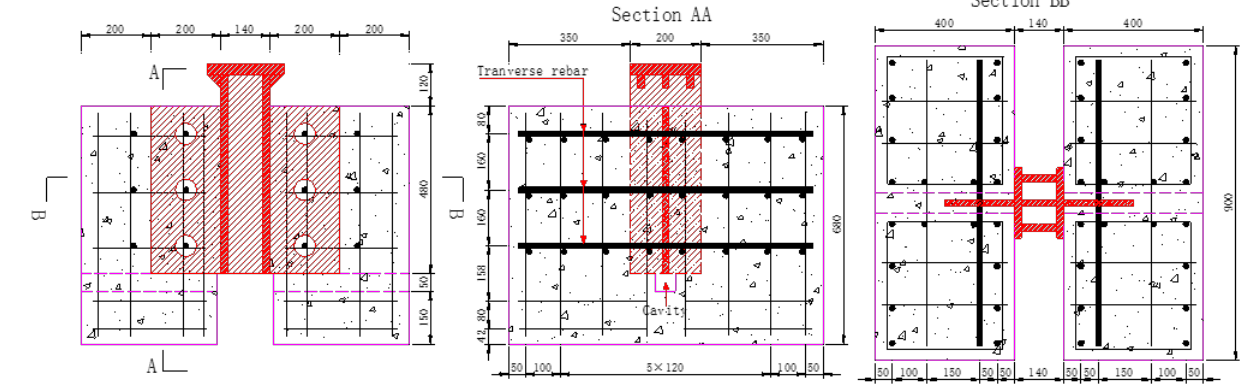
Figure 1. Dimensions of push-out specimens and perforated rib: BH-UN (unit: mm).